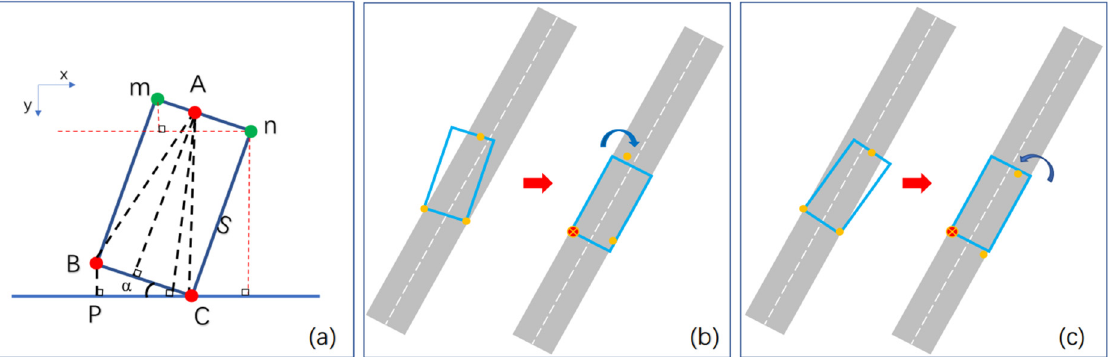
Figure 3. The definition of the initial window ( a ) and two cases of adjusting the positions of the initial window ( b , c ), where points A, B, and C are determined manually.